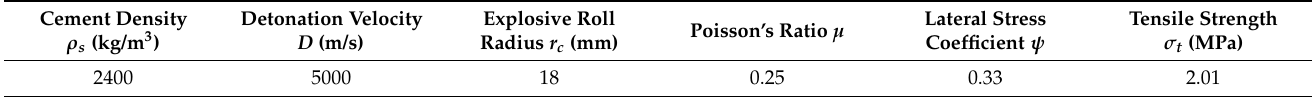
Table 6. Blasting fracture zone calculation